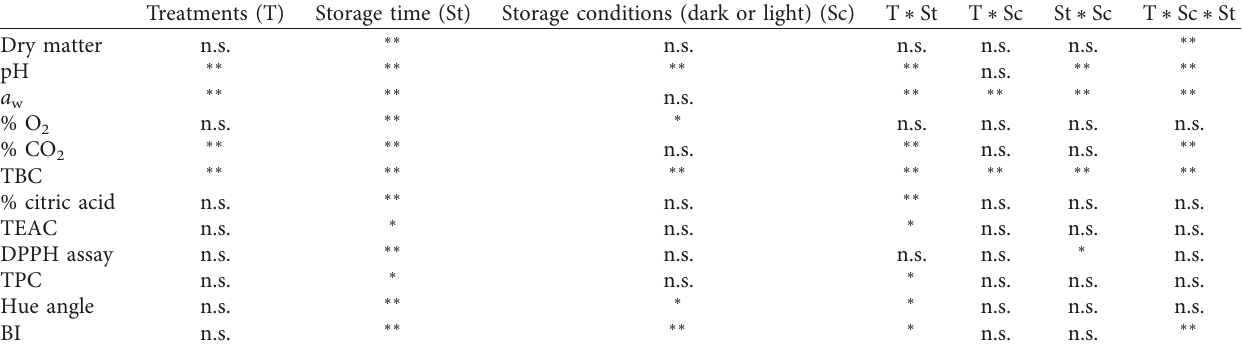
Figure 1: Effect of dark (a) and light (b) conditions on headspace gas composition of Valeriana pretreated leaves stored for sixteen Table 1: Results of multivariate analysis for some physicochemical parameters of Valeriana leaves with respect to different variables and their interactions.